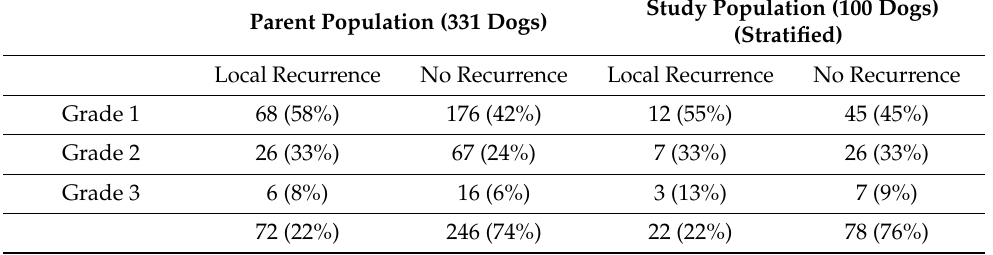
Table 1. Comparison of the rates of tumour grade and rates of local recurrence in the parent population and the study population after stratification. Patients were randomly selected from the parent population to provide equitable rates of recurrence by